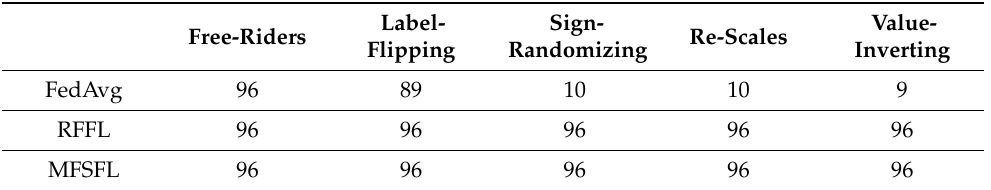
Table 3. Maximum accuracy (%) of five attack modes for MNIST under UNI with 10 G_P and additional 20% M_P.